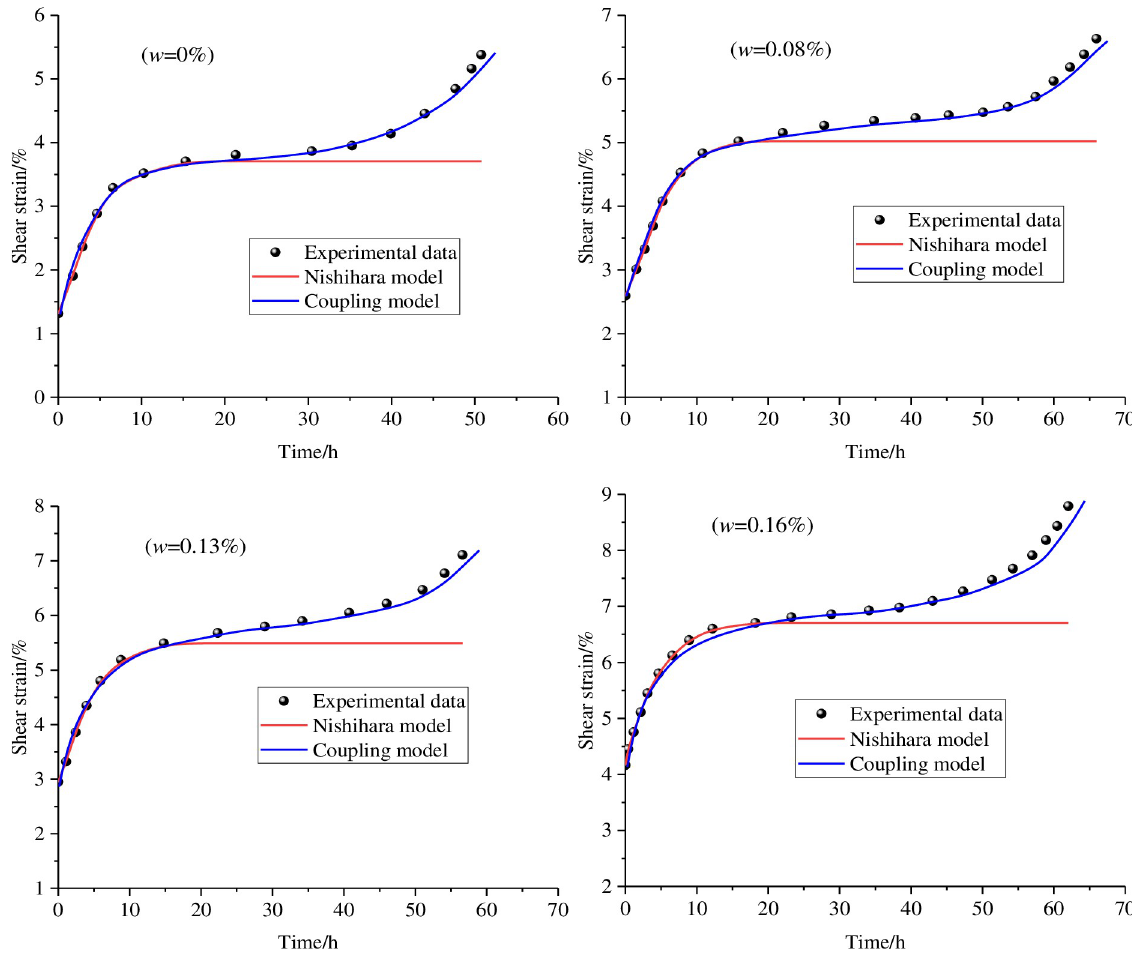
Fig 13. Comparison curve between test data and coupling